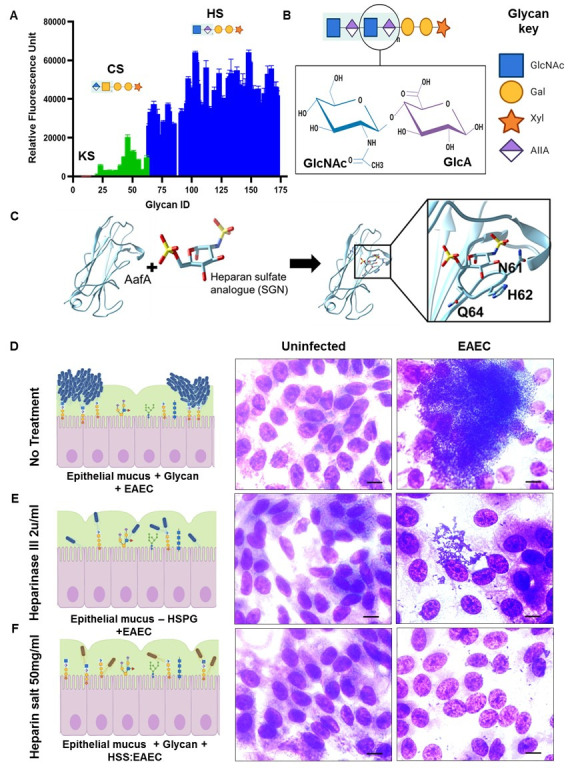
HSPG mediates adherence of EAEC to HIEMs.(A) GAG microarray of AafA shows high affinity binding to heparan sulfate GAGs. (B) shows the core chemical structure of HSPG. (C) Docking of SGN molecule on AafA reveals electrostatic interactions mediated by the residues H62, N61 and Q64. (D-F) Removal of HSPG by pretreatment of HIEs with heparinase III or addition of Heparan Sodium Salt (HSS) to EAEC as a competitive inhibitor exhibited reduced EAEC adherence on HIEs. Representative images, scale bars indicate 10μm.